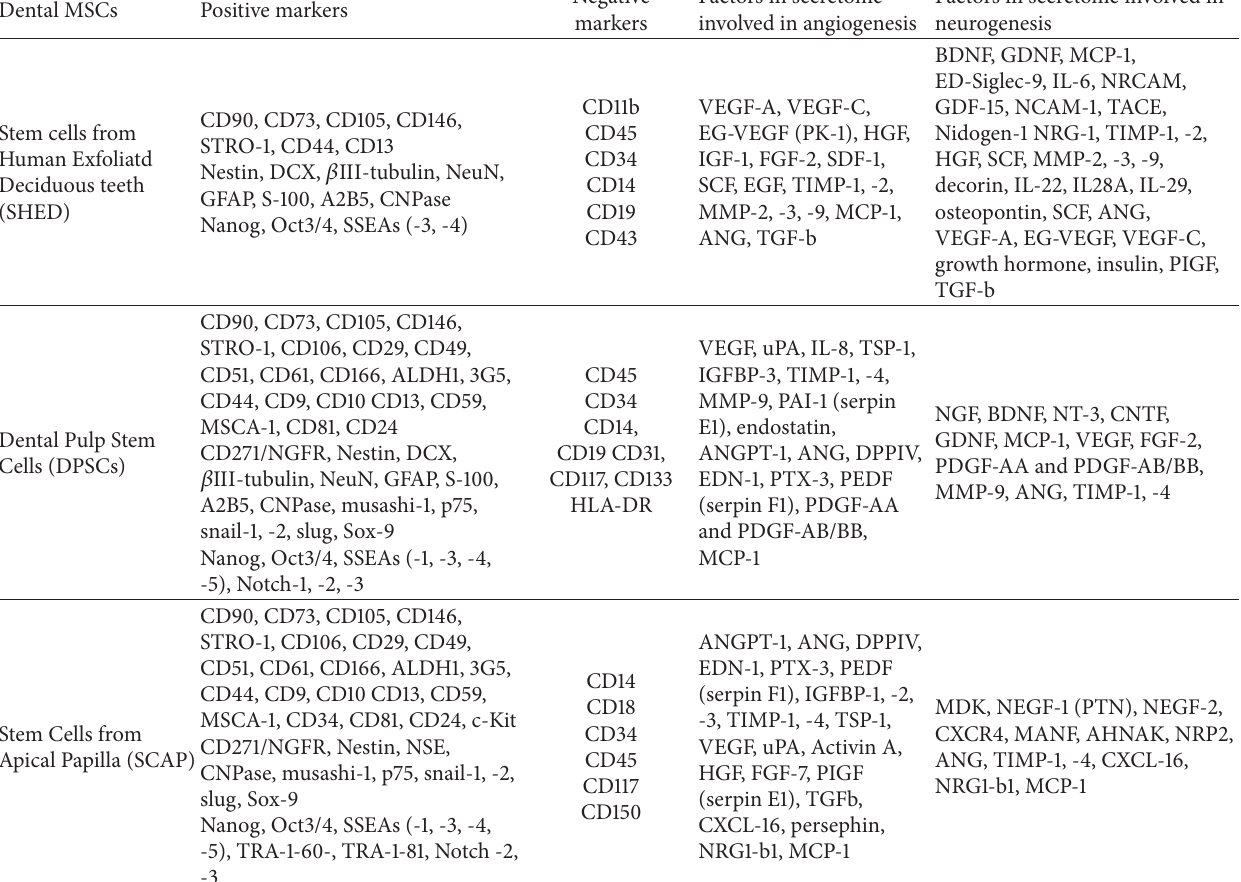
Table 1: Marker expression in dental MSCs (SHED, DPSCs, and SCAP) and factors identified in their secretomes. Dental MSCs